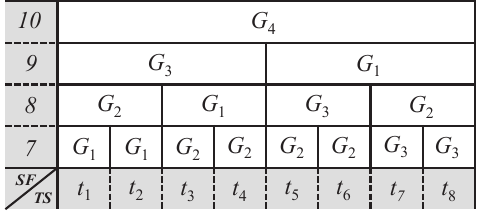
Figure 3. An example of resource allocations for GACK